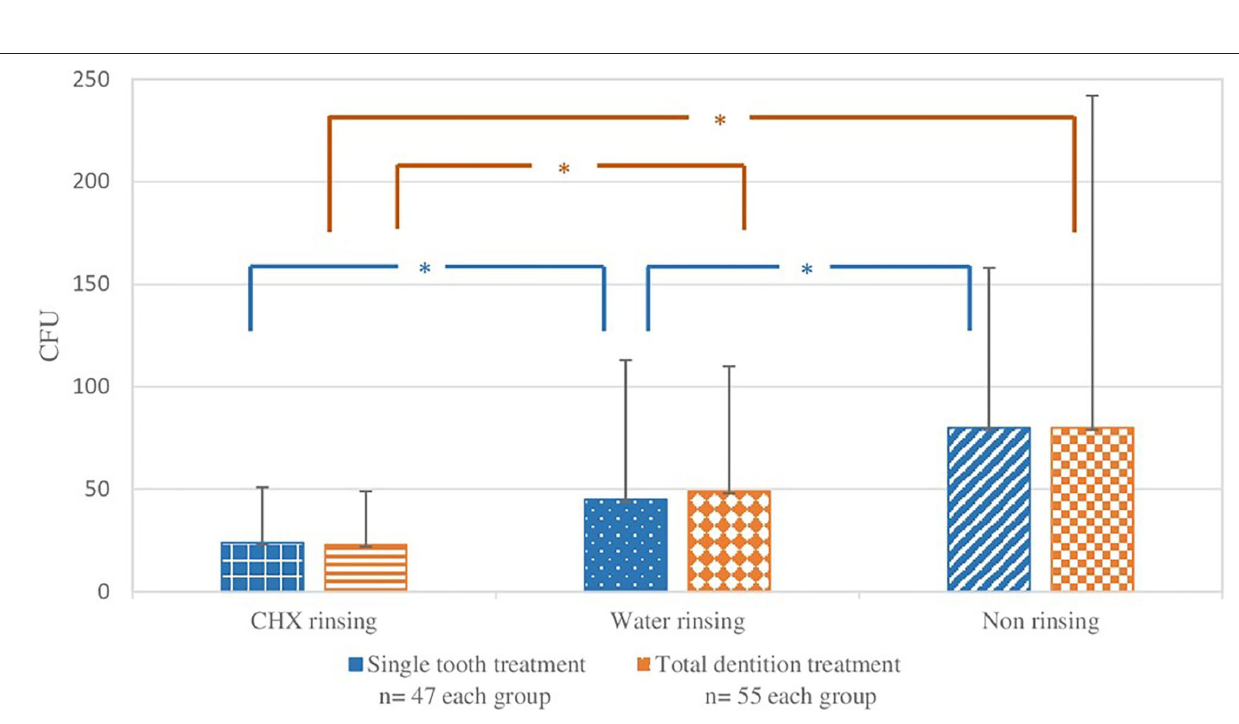
Frontiers in Medicine |